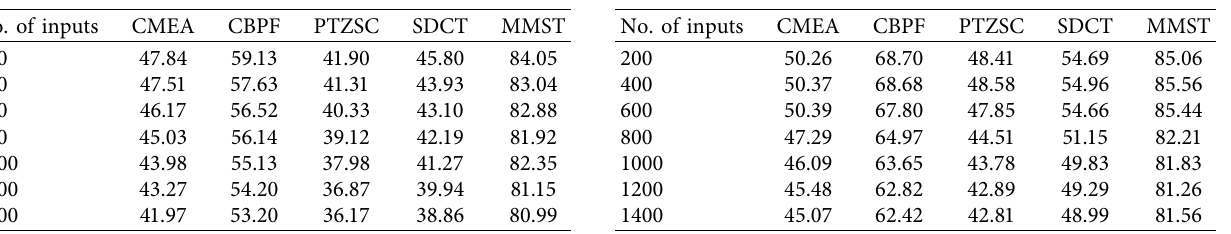
Table 1: Comparison of mulched soil management.